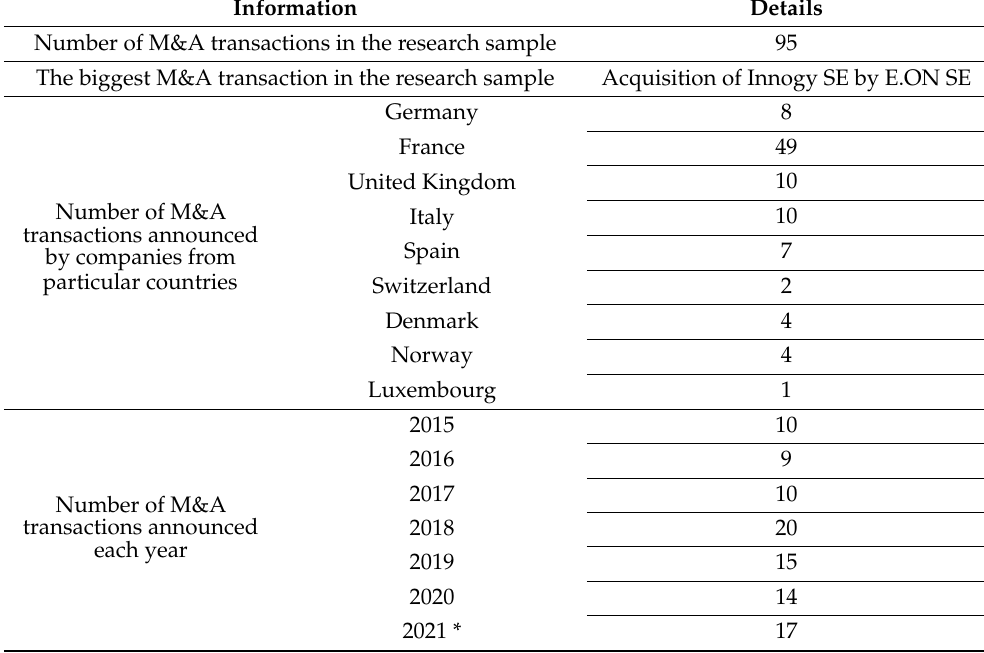
Table 1. Key information about the research